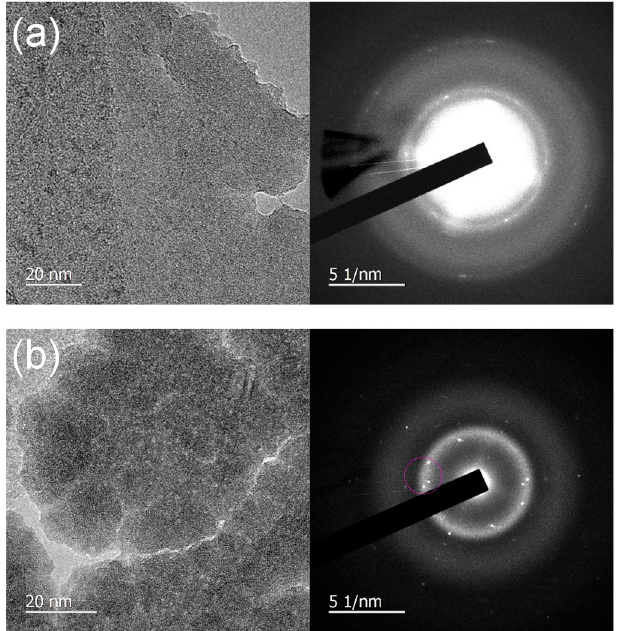
Figure 5. TEM image and diffraction pattern of ( a ) 10-nm thick alumina-graphene film and ( b ) 10-nm hafnia-graphene film suspended on a TEM grid.